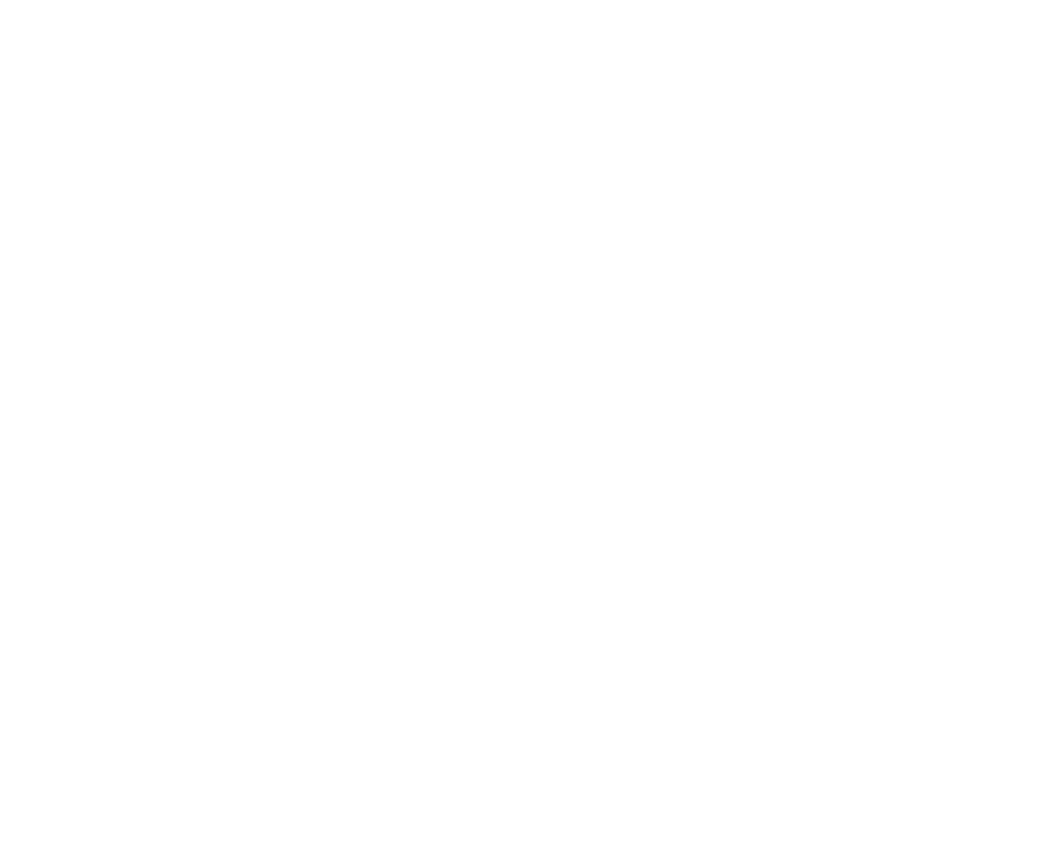
FIGURE A5 | Not all iPSC lines are capable of producing transwell intestinal cell monolayers with characteristics suggestive of tight junction formation. (A) Morphology of during C2128A transwell differentiation shows that cells lose dense structures during differentiation; however, the monolayer begins to pull into itself during